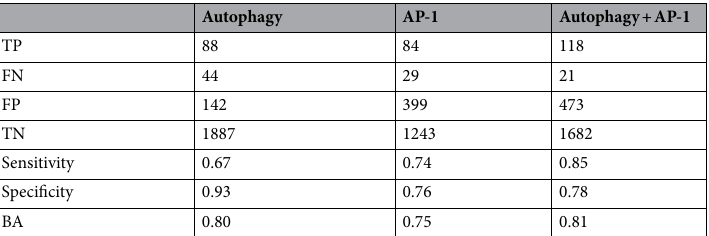
Table 1. Activity concordance between the SARS-CoV-2 CPE assay and top correlated assays. TP True positive; number of compounds active in both the SARS-CoV-2 and the other assay. FN false negative; number of compounds active in the SARS-CoV-2 assay but not active in the other assay. FP false positive; number of compounds not active in the SARS-CoV-2 assay but active in the other assay. TN = True negative; number of compounds inactive in both assays. BA balanced accuracy; (sensitivity + specificity)/2. Sensitivity = TP/ (TP + FN). Specificity = TN/(TN +